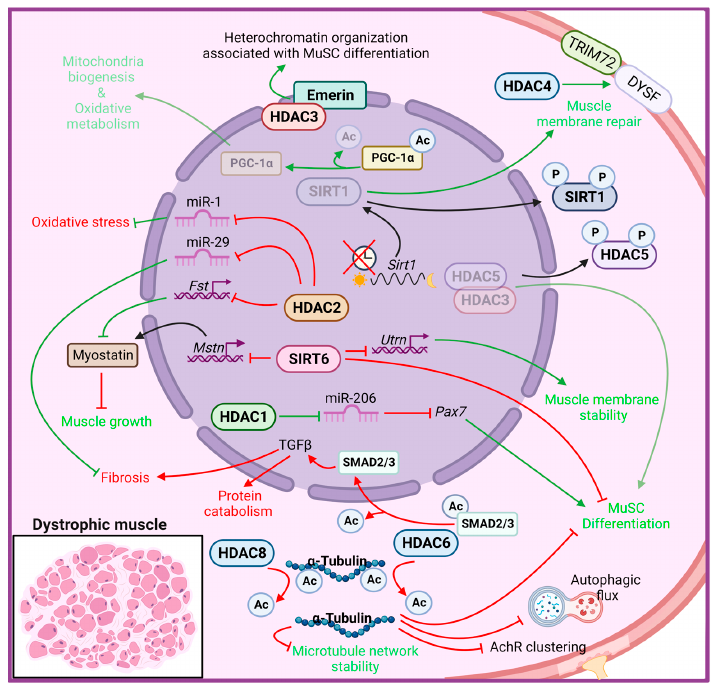
Figure 1. Histone deacetylase functions in muscle dystrophy condition. The cellular responses that promote MD progression are indicated in red, while in green those that counteract MD pathological features. AChR: acetylcholine receptor; Ac: acetyl group; Fst : follistatin; Mstn : myostatin; Utrn : utrophin; HDAC: histone deacetylase; SIRT: sirtuin; DYSF: Dysferlin; PGC-1 α : peroxisome proliferator-activated receptor, gamma, coactivator 1 alpha; TGF- β : transforming growth factor beta.